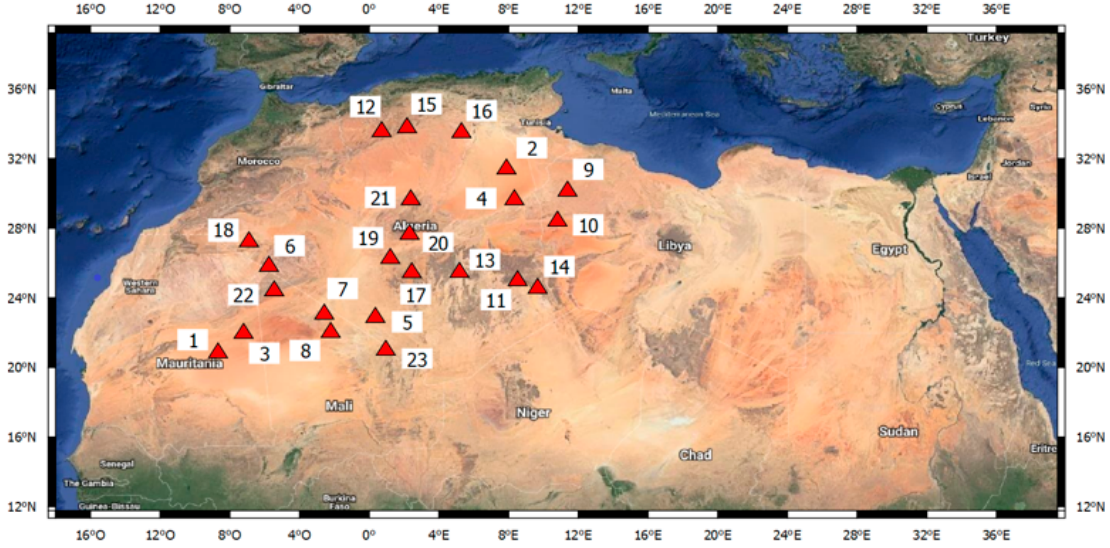
Figure 1. Illustration of the studied site: the Sahara desert.